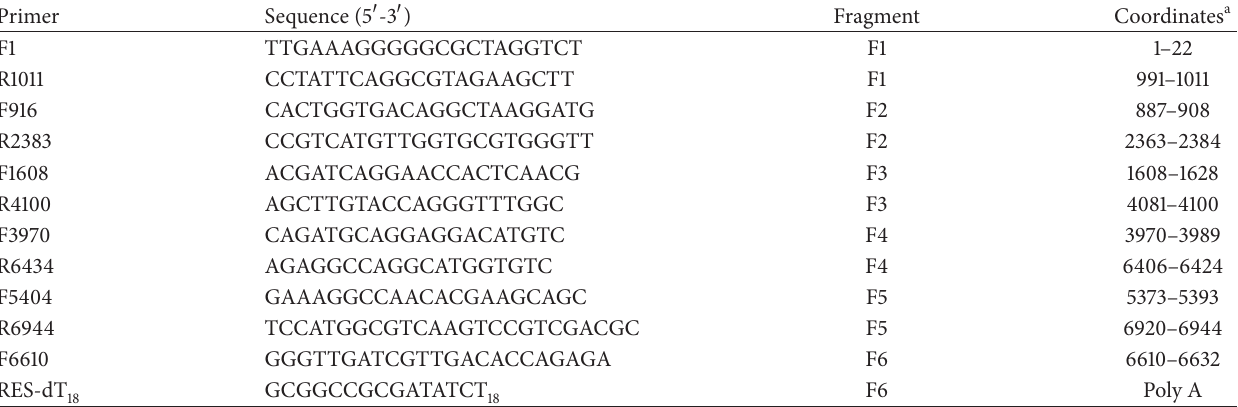
Table 1: Primers used for amplification of the FMDV ZB strain